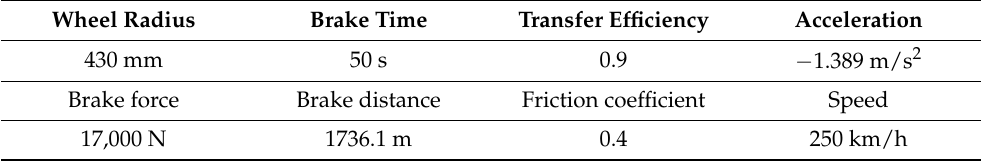
Table 3. The braking operation parameters.